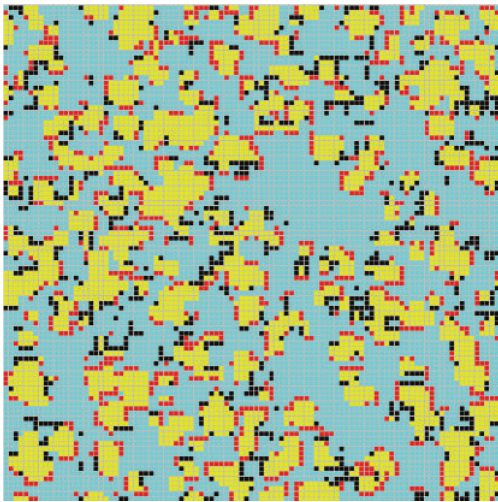
Figure 3: The snap after 20 generations for the greedy (G) and altruist (A) strategies, initially with 50% altruist and 50% greedy players.